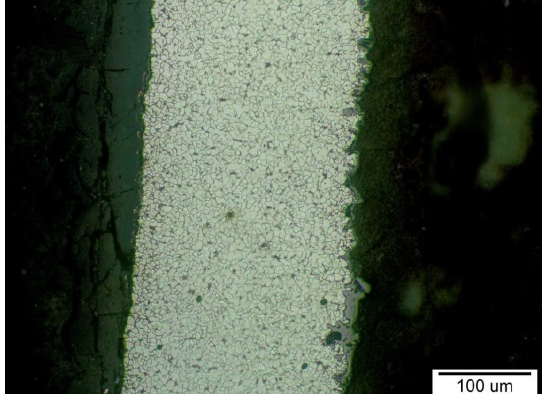
Figure 14. The outer surface (left) and the inner surface (right) of the T3 sample with a corrosion layer on the inner surface. On the outer surface is a visible part of the corrosion layer that remained attached to the surface; etch, Nital.